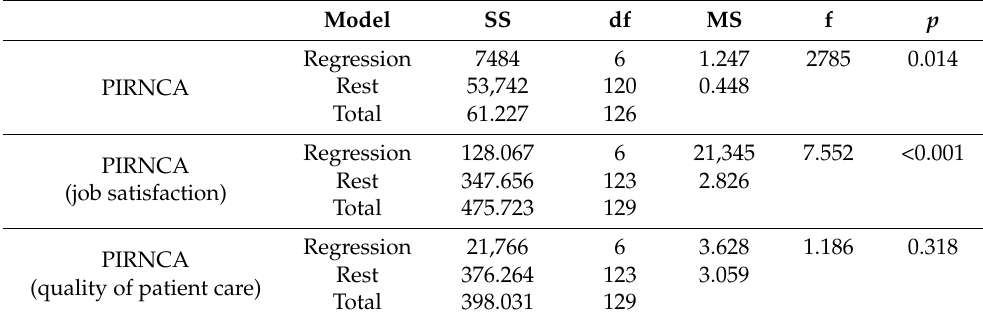
Table 4. Analysis of variance of the influence of sociodemographic characteristics on the rationing of nursing care, job satisfaction and the quality of patient care. Model SS df